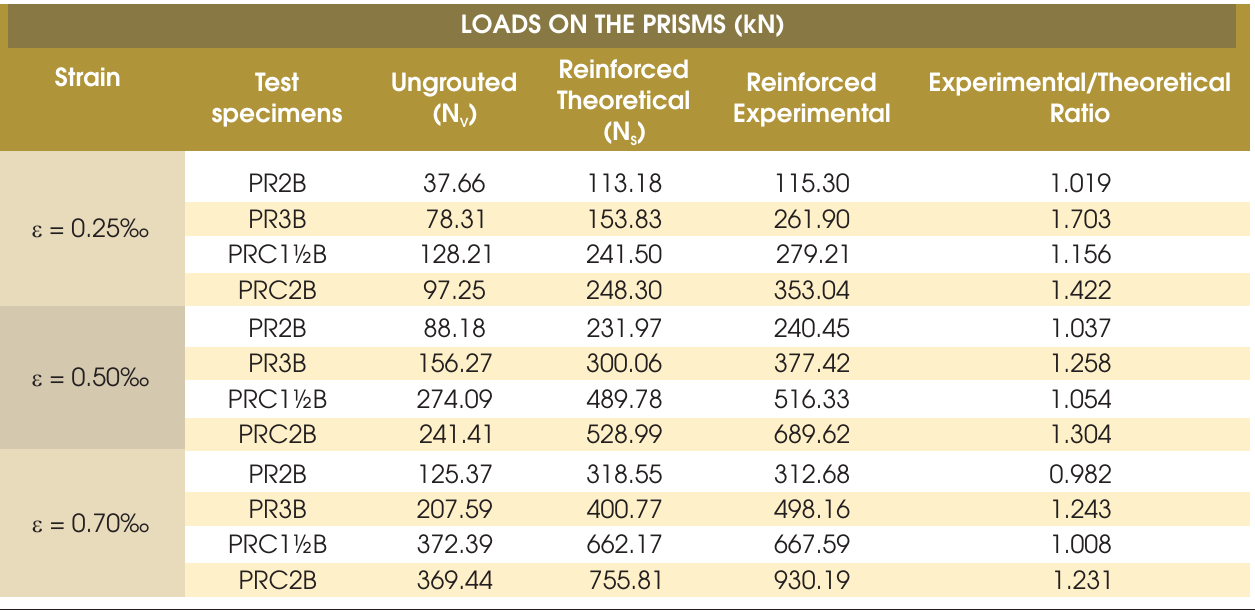
Table 5 – Comparison of mean theoretical and experimental loads for some of the strains – (Model I) LOADS ON THE PRISMS (kN)